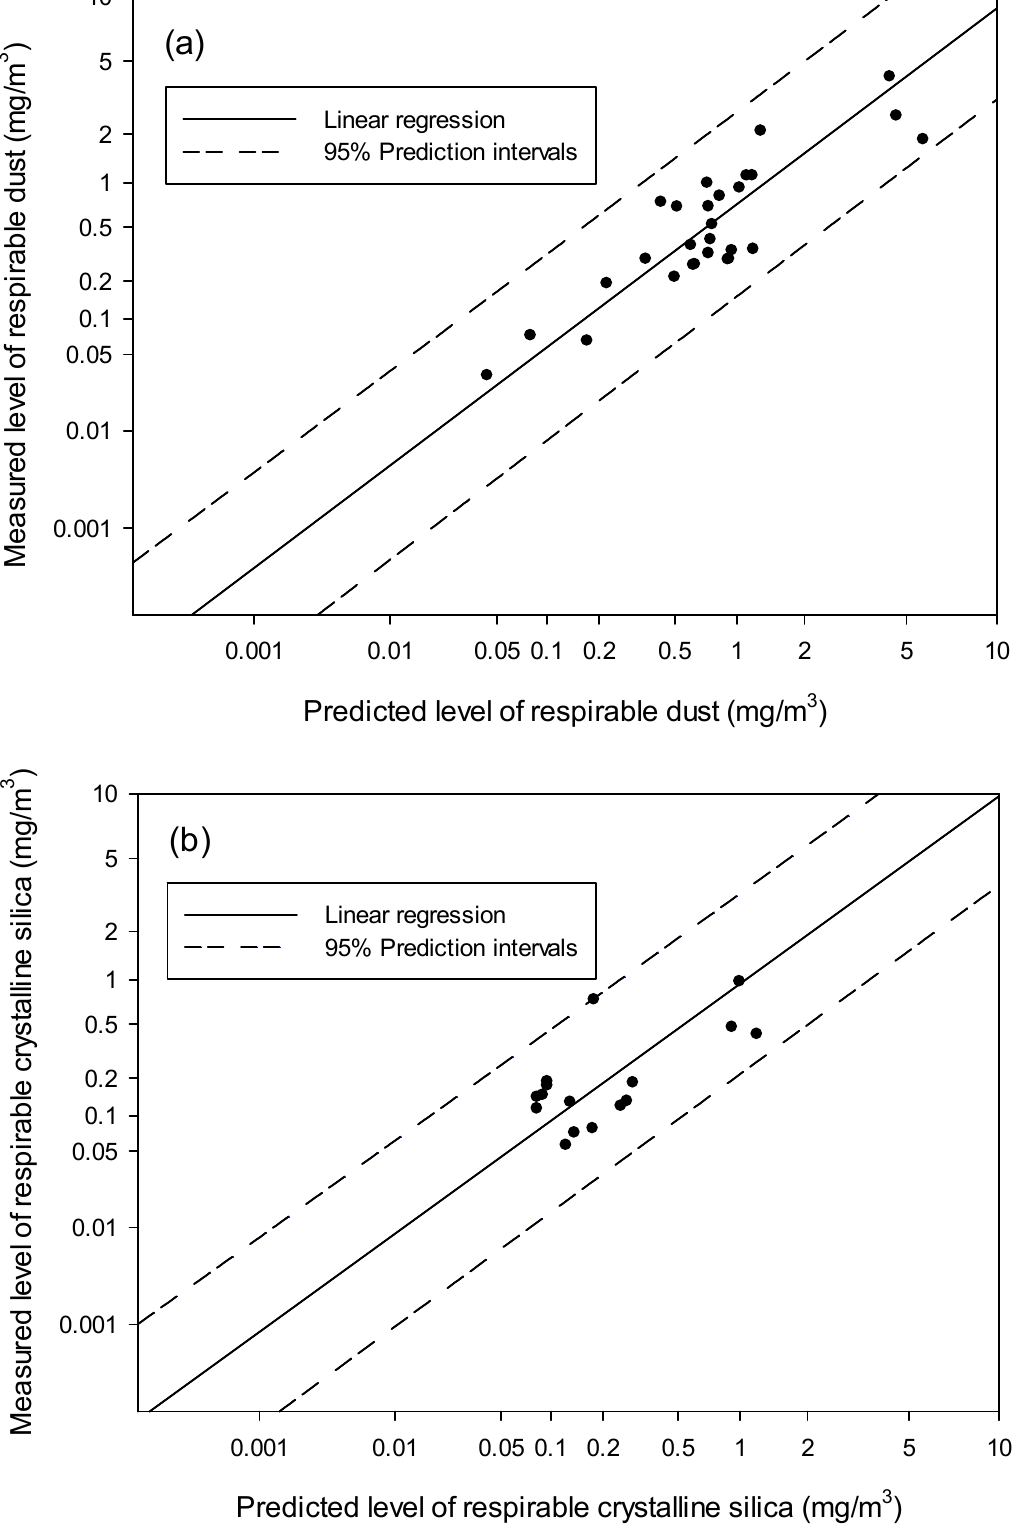
Figure 2. Comparisons of predicted and measured levels of ( a ) respirable dust ( n = 30) and ( b ) respirable crystalline silica ( n = 17) above the limit of detection among workers from Factories A–C.